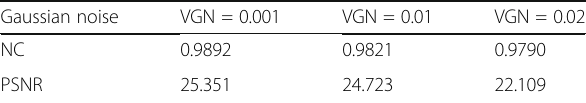
Table 3 Adding the Gaussian noise attack with Example 2 Gaussian noise